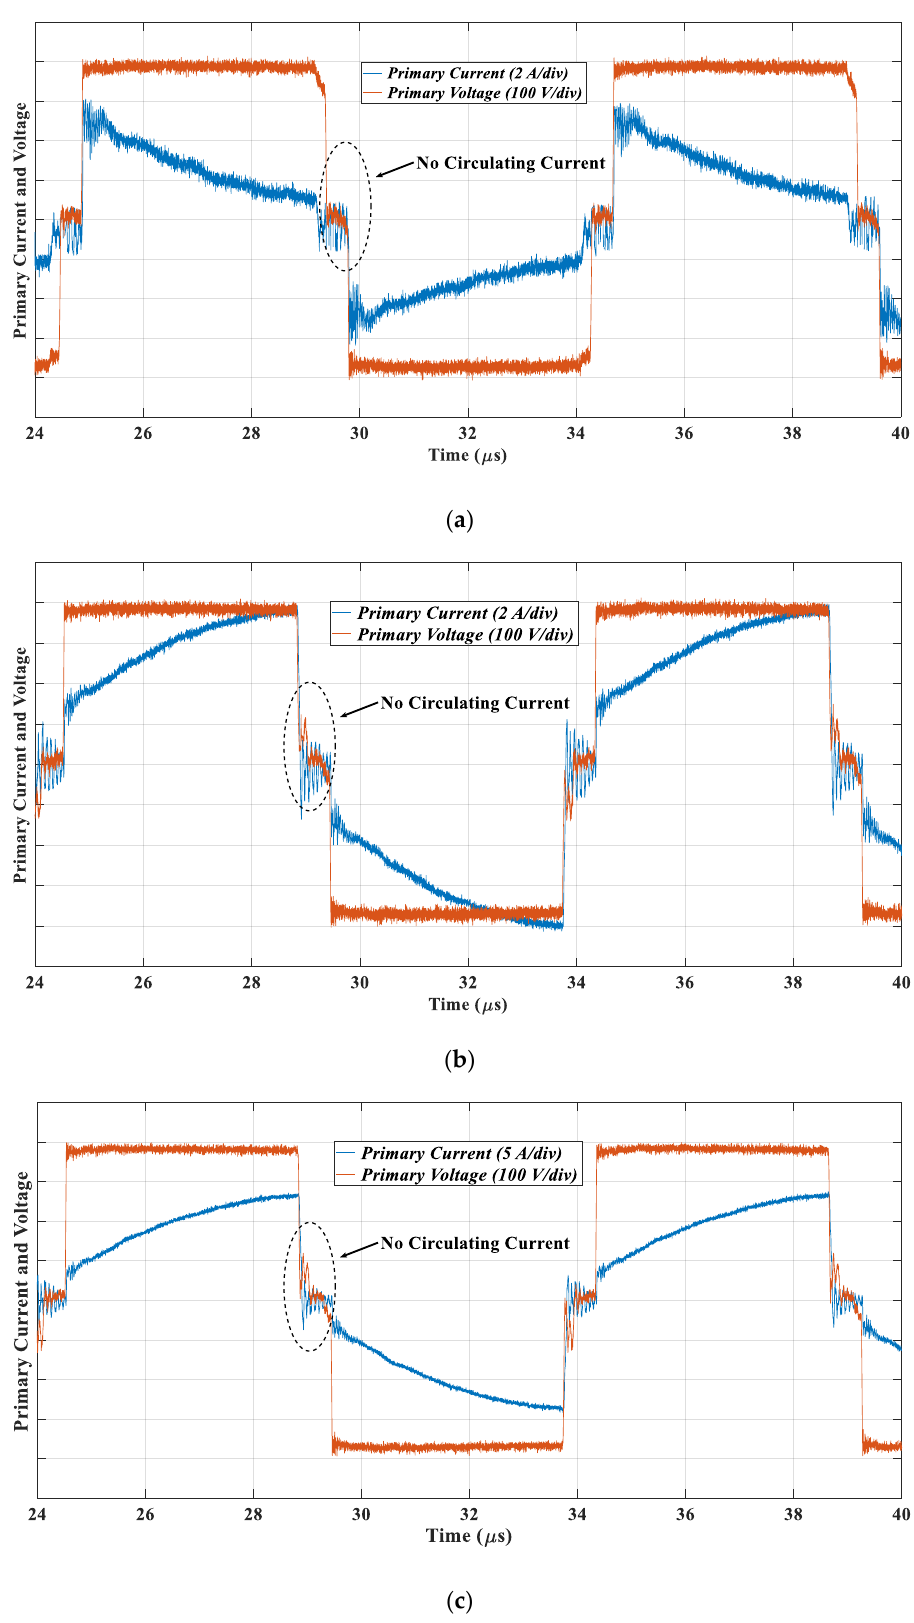
Figure 9. Measured operation waveforms at 100 kHz and output powers of ( a ) 800 W, ( b ) 3 kW,